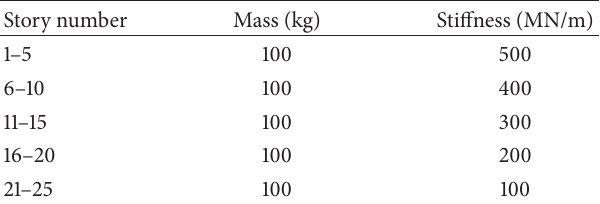
Table 5: The properties of the 25-story shear